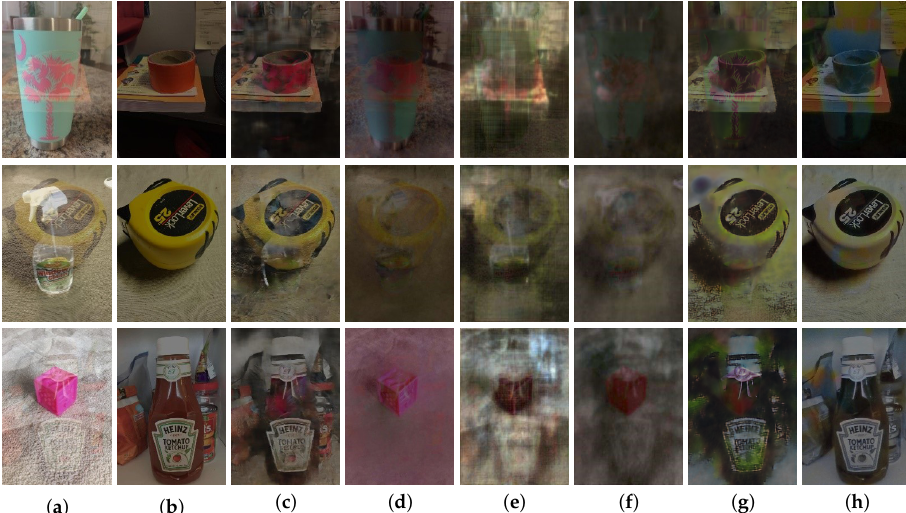
Figure 11. Qualitative comparison of the transmission removal results on synthetic mixture images. ( a ) Mixture image, ( b ) Ground truth reflection, ( c ) [13], ( d ) [14], ( e ) [16], ( f ) [17], ( g ) Ours(a), and ( h )